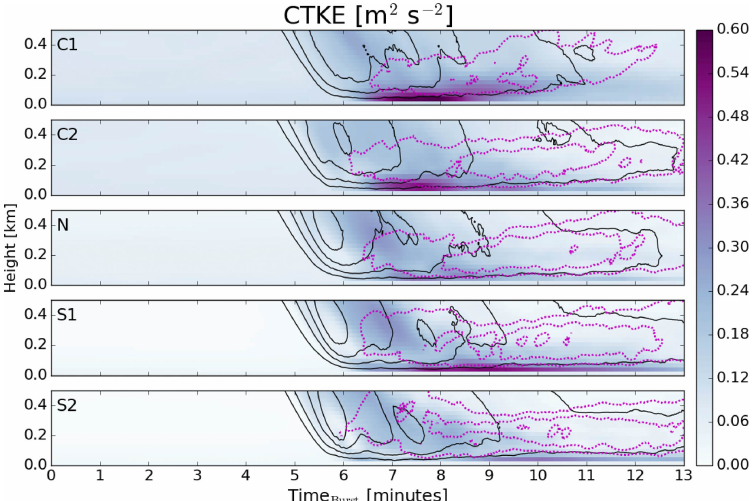
Figure 13. The same as Fig. 8 but for coherent turbulent kinetic energy (CTKE).